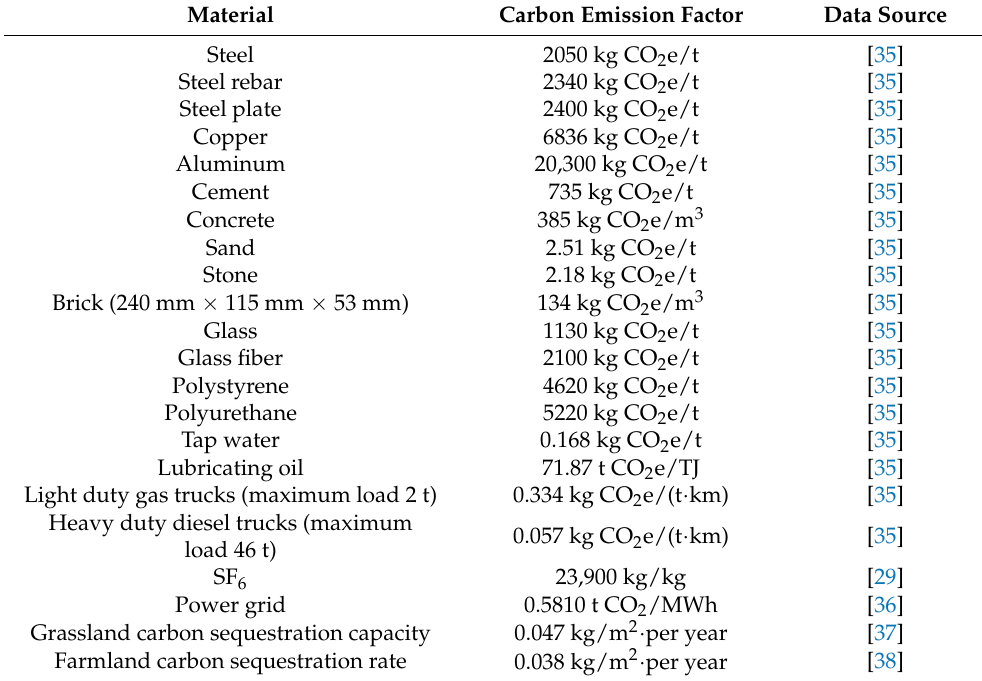
Table 4. Main materials and energy carbon emission factor/carbon sequestration